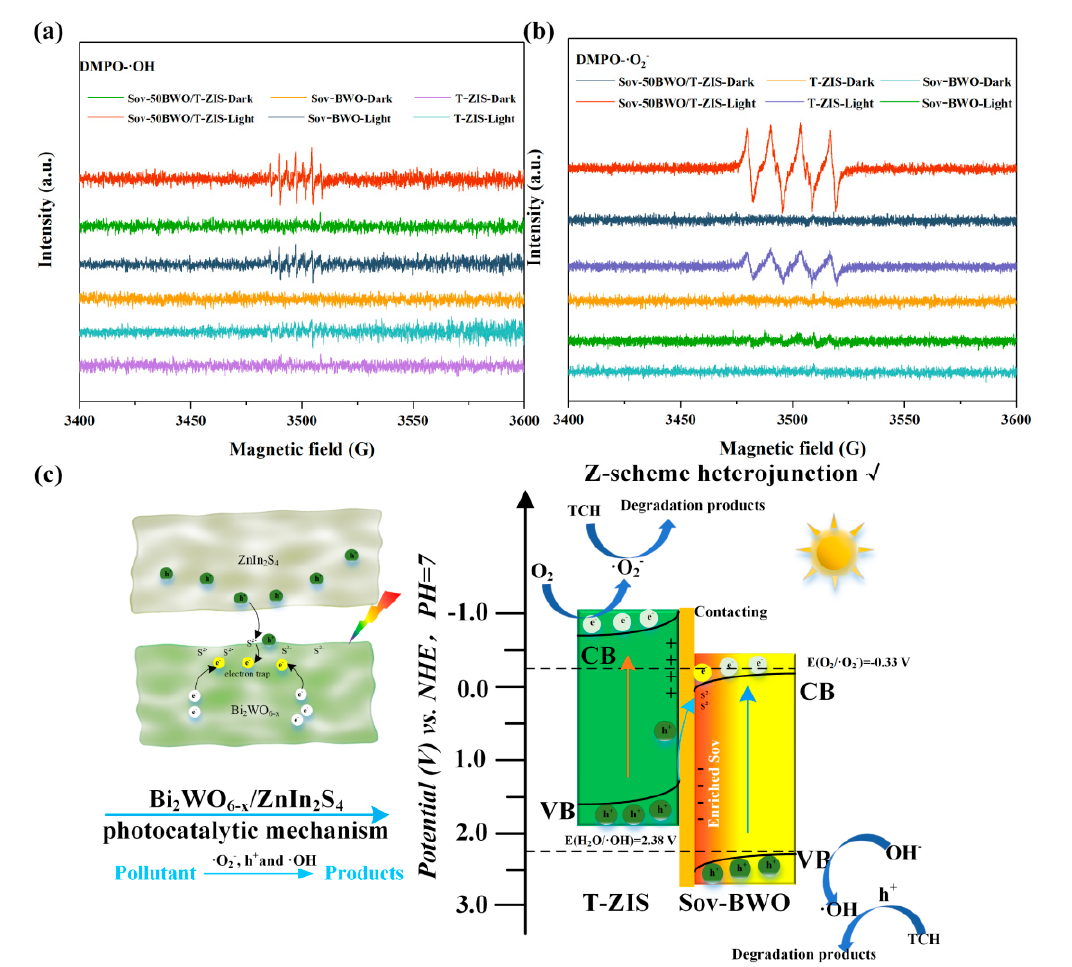
Figure 6. In situ EPR spectra of radical adducts trapped by ( a ) DMPO − ·OH and ( b ) DMPO − ·O 2 − ( c ) The possible photocatalytic mechanism.